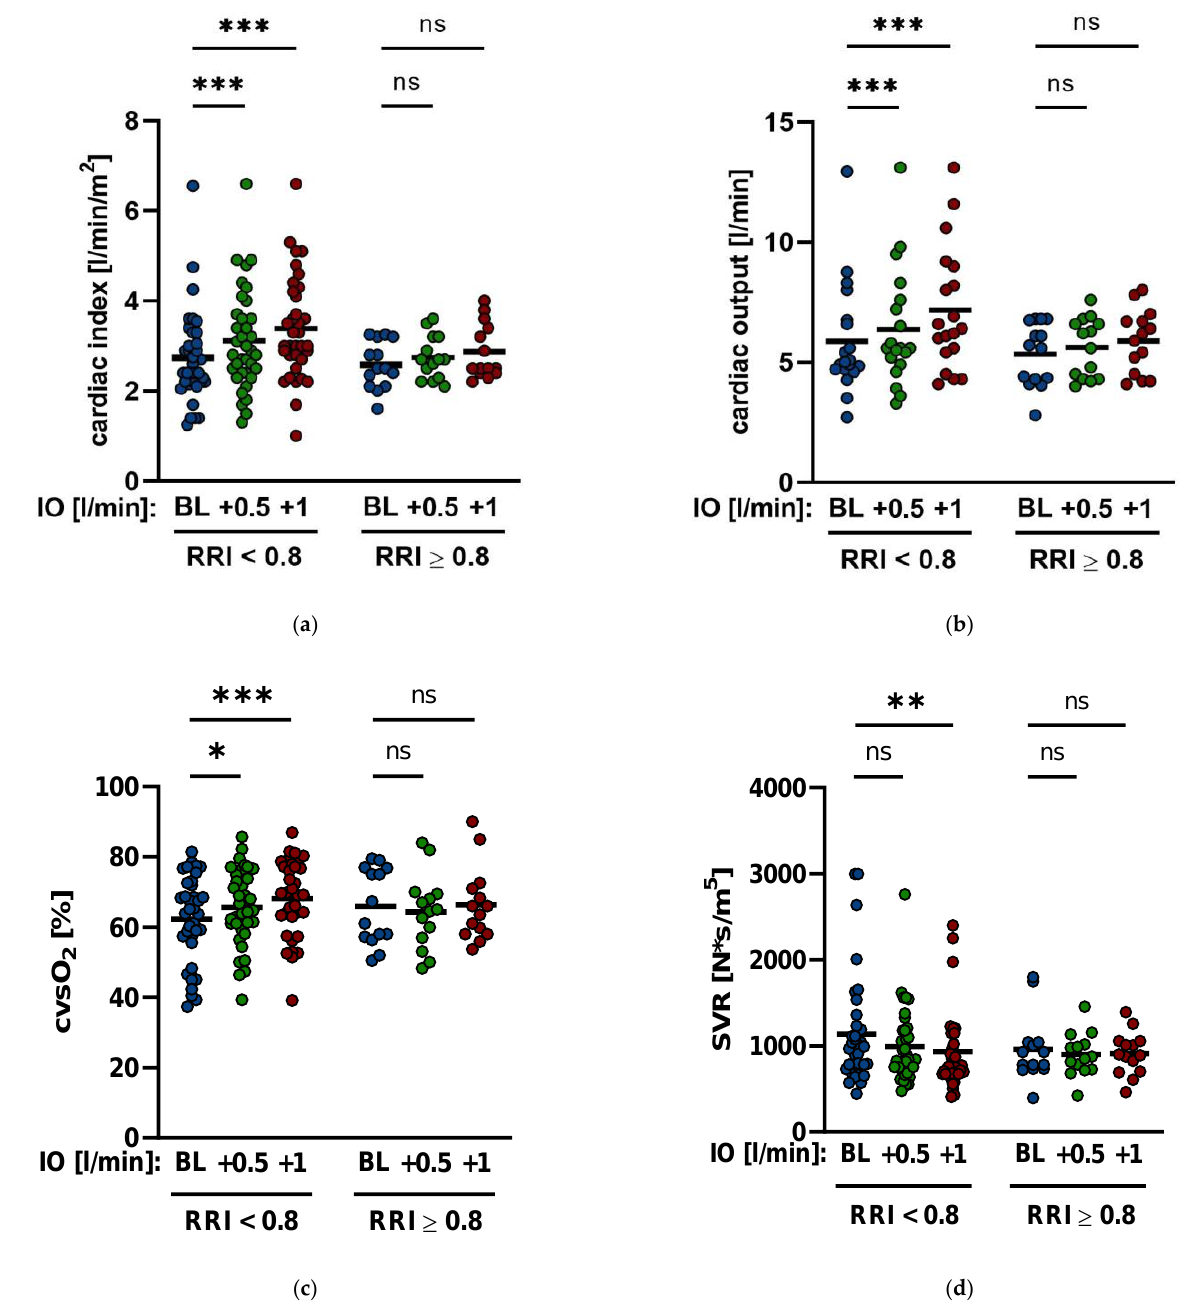
Figure 6. Hemodynamic changes by Impella ® output and RRI. ( a ). Cardiac Index (CI) by Impella output (IO) and RRI. ( b ). Cardiac output (CO) by Impella output (IO) and RRI. In patients with baseline RRI ≥ 0.8 CO showed no significant elevation from baseline 5.3 ± 1.4 L/min to 5.81 ± 1.2 L/min p = 0.06 and 6.18 ± 1.3 L/min p = 0.09, respectively. ( c ). Central venous oxygen saturation (cvsO 2 ) by Impella output (IO) and RRI. ( d ): Systemic vascular resistance (SVR) by Impella output and RRI. In patients with baseline RRI< 0.8, SVR could be reduced significantly when increasing Impella ® output by 1.0 L/min from baseline 1064 ± 558 s·cm −5 to 932 ± 483 s·cm −5 p = 0.04 (BL: baseline; ns: not significant, p ≥ 0.05; *: p < 0.05, **: p ≤ 0.01, ***: p < 0.001). Knowing that RRI values between 0.6 and 0.7 are considered to be in the normal range [17] and that RRI values ≥ 0.7 indicate the onset of AKI [23], we observed that in patients with higher baseline RRI values ( ≥ 0.8), the RRI dropped as low as mean to 0.69